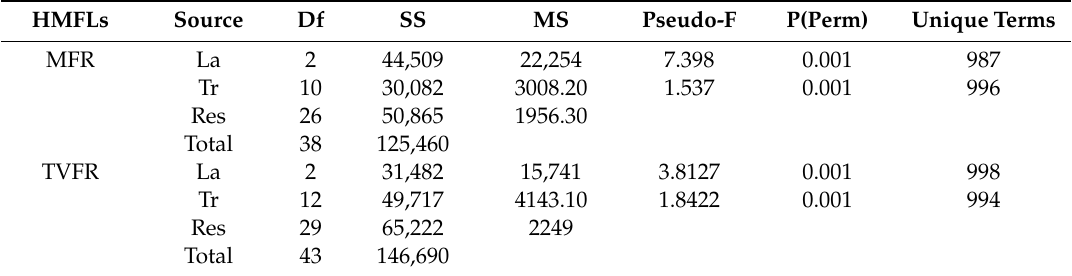
Figure 5. Multi-dimensional scaling (MDS) of local assemblage of different land use regimes in MFR and TVFRs. Table 3. PERMANOVA results for patterns of β -diversity of HMFL along a land use gradient in human modified forest landscape (HMFL) at MFR (Mafhela Forest Reserve) and TVFR (Thathe Vondo Forest Reserve).